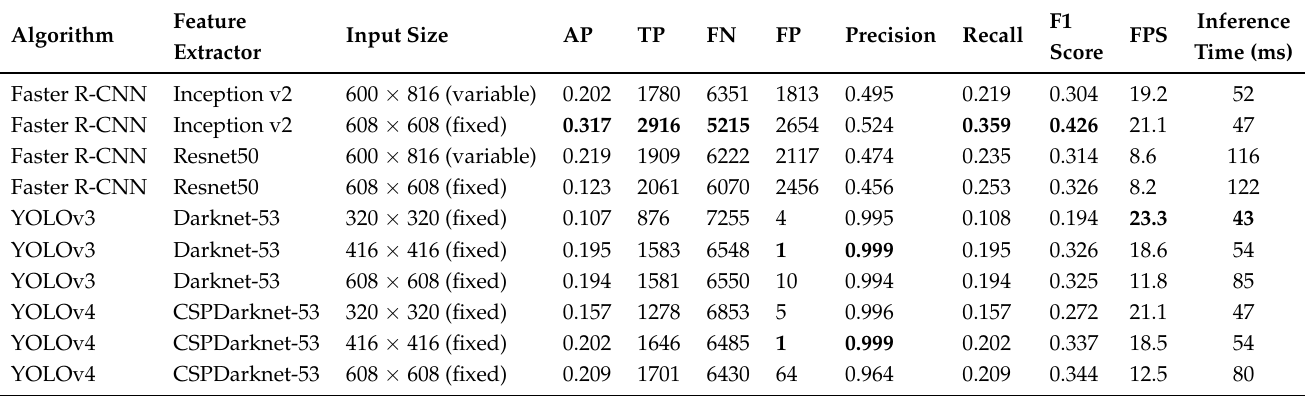
Table 11. Detailed results of different configurations of YOLOv3, YOLOv4, and Faster R-CNN, on Stanford dataset. The default configuration of Faster R-CNN allows a variable input size that conserves the aspect ration of the image. In this case, the input size shown is an average. The best results are shown in